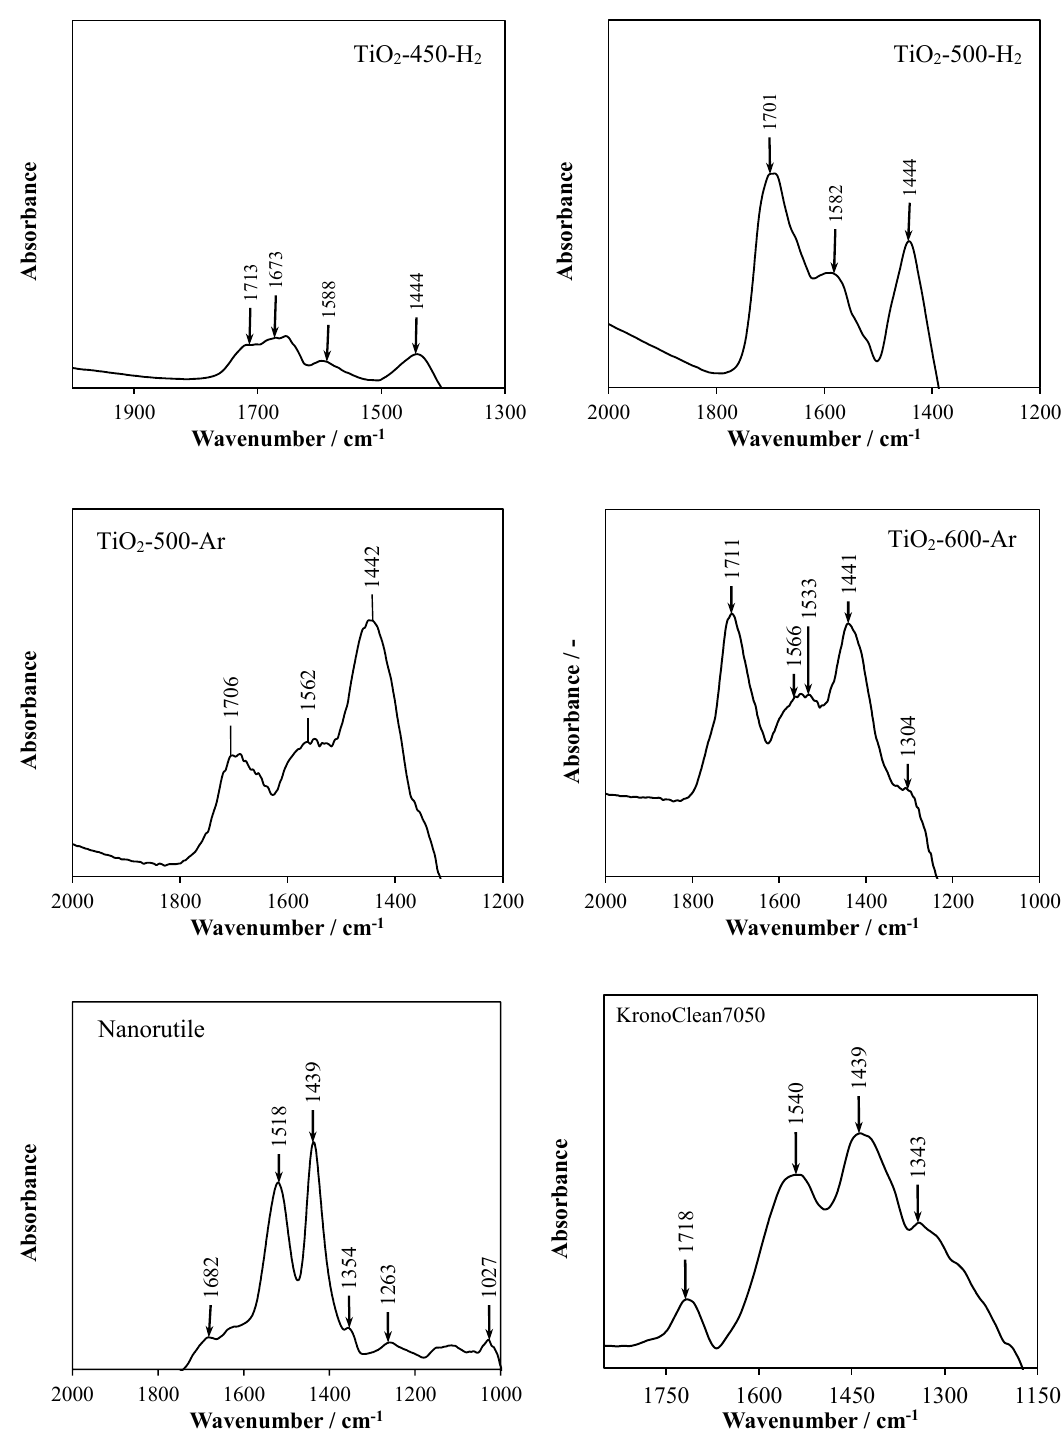
Figure 10. FTIR spectra of titania samples after photocatalytic decomposition of acetaldehyde—subtracted from these before adsorption.